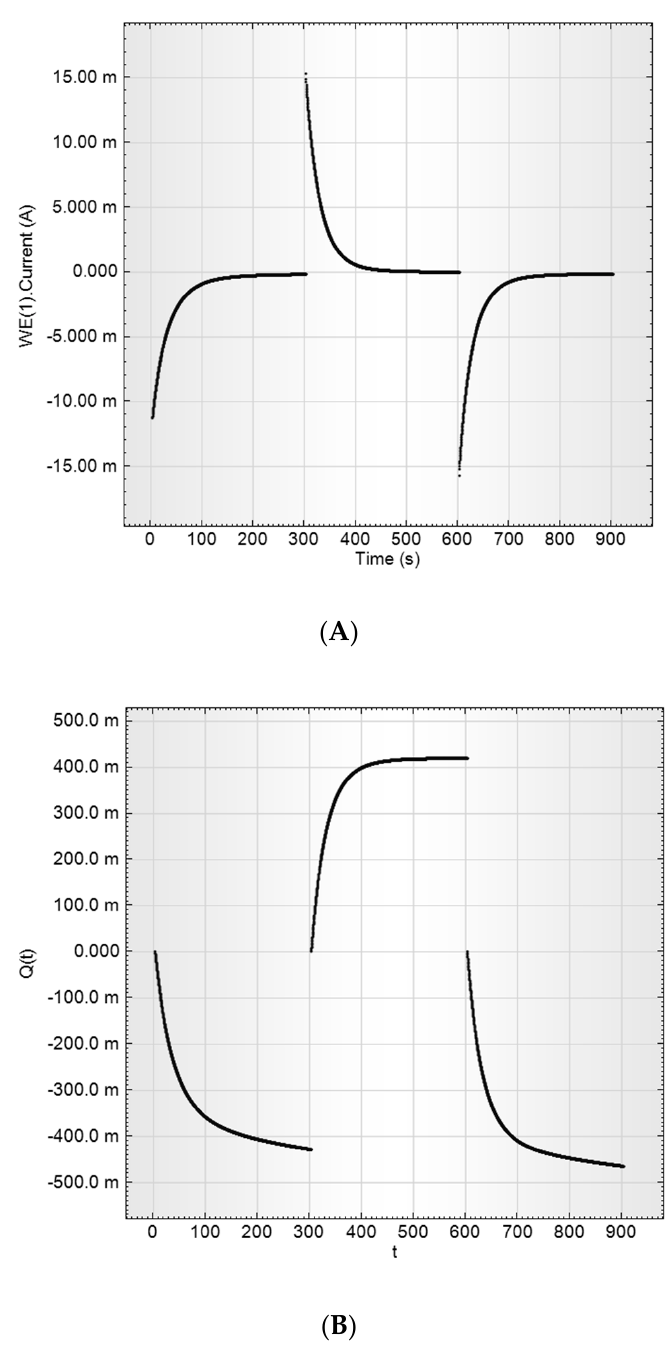
Figure 9. The charge-discharge curves of RF-900 sample (13.6 mg) in a 2M aqueous sulfuric acid solution. ( A ) is the charging current vs. time I (t). ( B ) is the current integral, that is, the charge of the supercapacitor, Q (t).